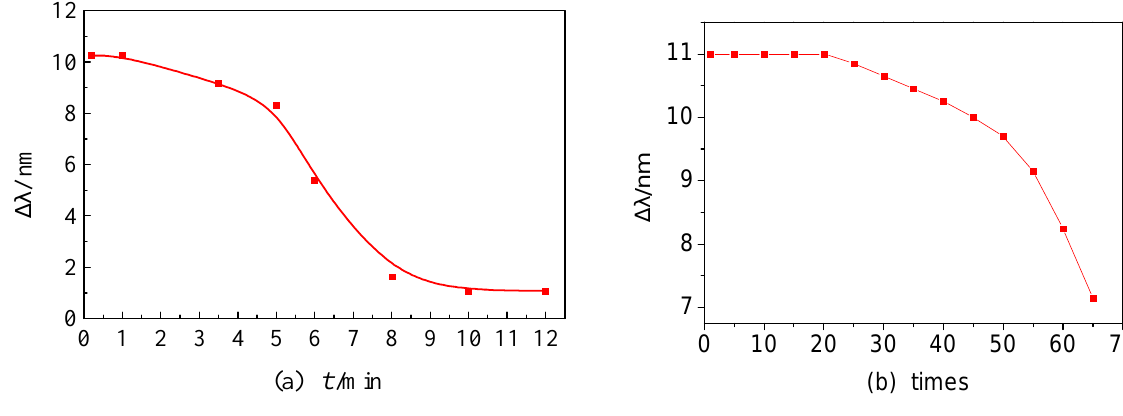
Figure 5. The regeneration of the sensor. (a) The elution curve of antibody-antigen composite from sensor membrane. (b) The resonance wavelength changes of the sensor after successive regeneration with 0.3 mol/L citrate